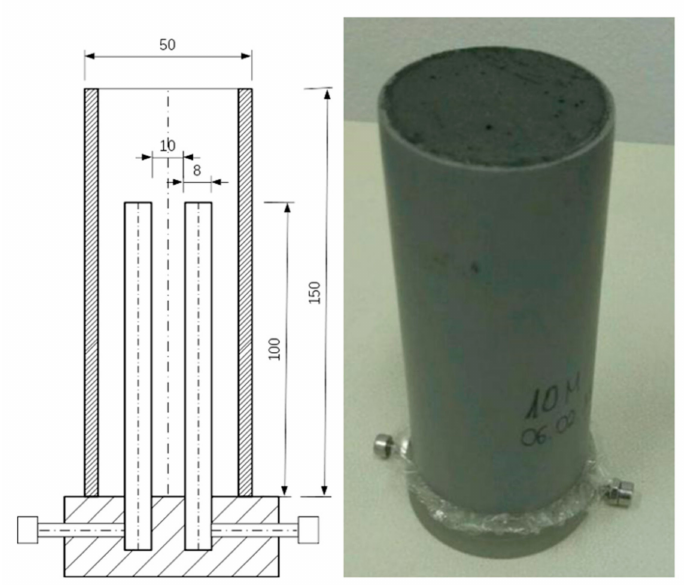
Figure 1. Schema of form containing electrodes and picture of geopolymer in